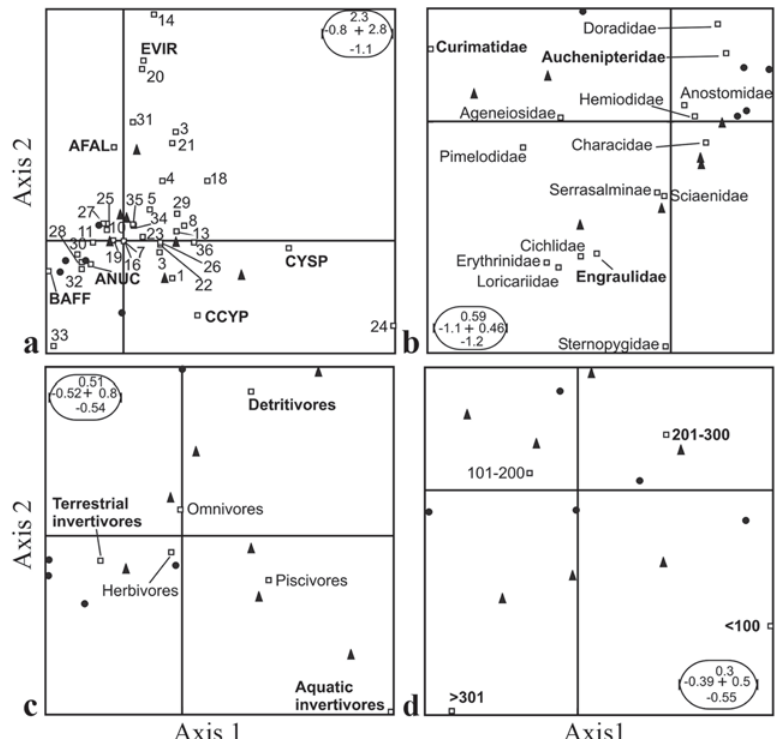
Fig. 4. Fish assemblage ordination resulting from a CA analysis using species (a), family (b), trophic guild (c), and MOS (d) descriptors in the downstream site, Comté River. Bold text indicates the species, family, trophic guild or MOS which contributes most to axes. Dots = samples taken during high waters; triangles = samples takes during low waters. Numbers correspond to fish species in Table 1. Axis scales are indicated in the small